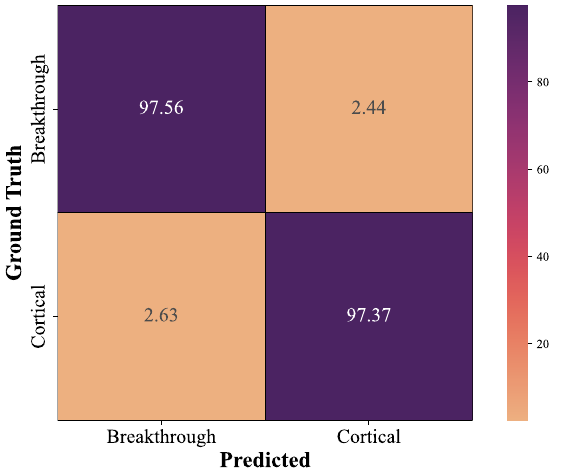
Figure 7. The confusion matrix for the proposed model (CNN-LSTM-Attention-Leaky ReLU) on Seibold’s dataset.